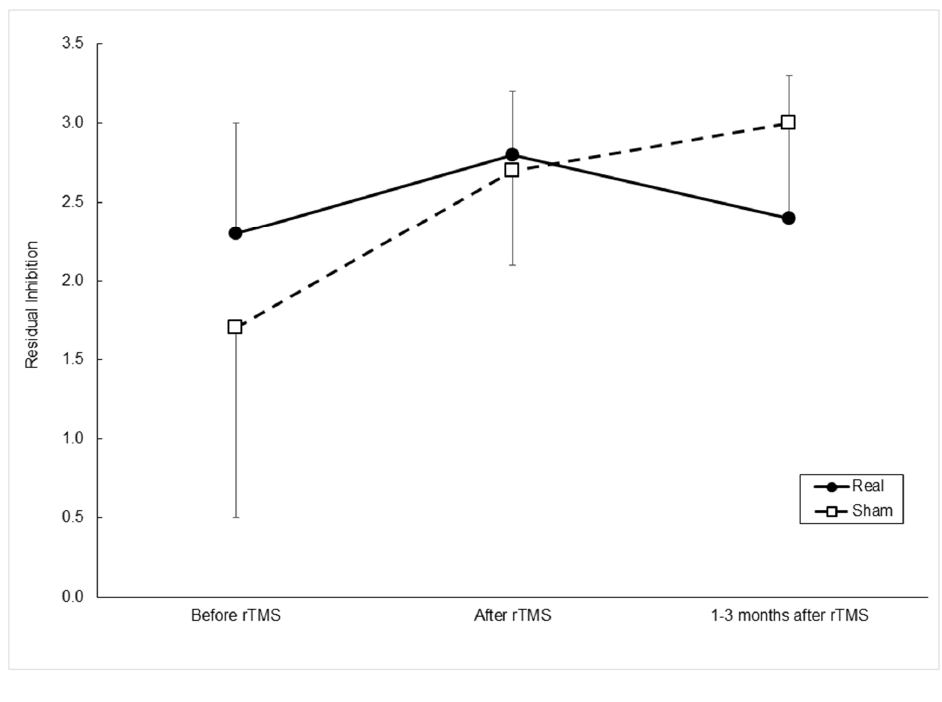
Figure 1. Outcome measurements between real and sham continuous theta-burst stimulation groups before brain stimulation, after brain stimulation on the 5th day, and at follow-up 1-3 months later. ( A ) The degree of annoyance of ear fullness, ( B ) duration of tinnitus, ( C ) visual analog scale (VAS) of tinnitus annoyance, ( D ) Tinnitus Handicap Inventory (THI), functional subscale, ( E ) THI, emotional subscale, ( F ) THI, catastrophic subscale, ( G ) THI, total score, ( H ) pitch, ( I ) loudness, ( J ) minimal masking level, and ( K ) residual inhibition. A generalized linear mixed model approach showed significant differences of changing pattern in VAS and MML over the three visits between two groups (( C ), p = 0.002 and ( K ), p = 0.033, respectively). This was supposed to be due to the large changes over time in the sham group, but there were no significant differences in the mean values of VAS and MML in paired analyses in each group (all ps > 0.2). Besides, there were no significant differences in the mean values of VAS and MML between the two groups at each visit (ps > 0.2 and ps > 0.1, respectively).